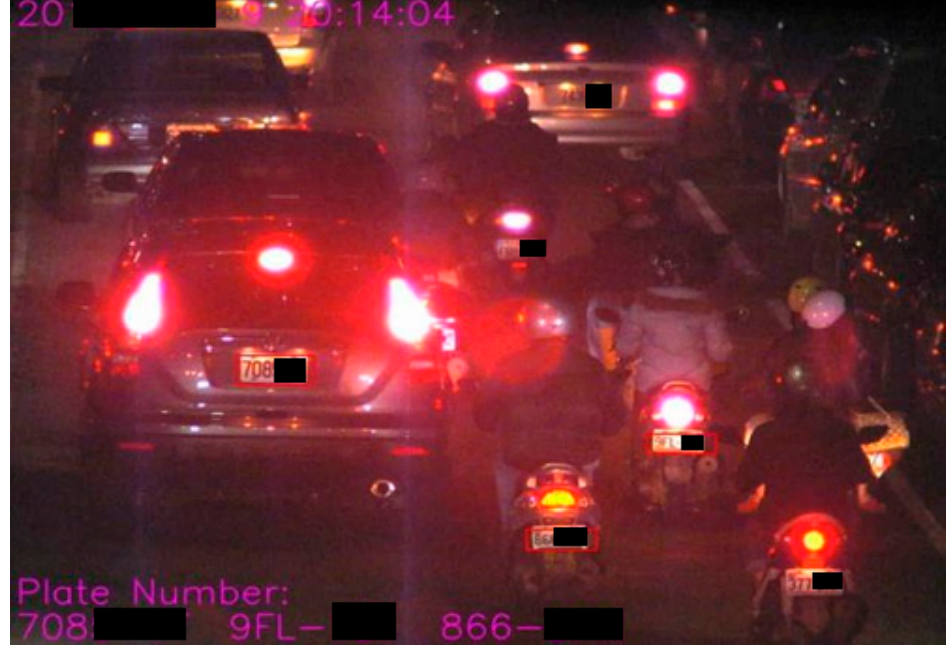
Figure 7. A schematic diagram for detecting the track of target vehicle.